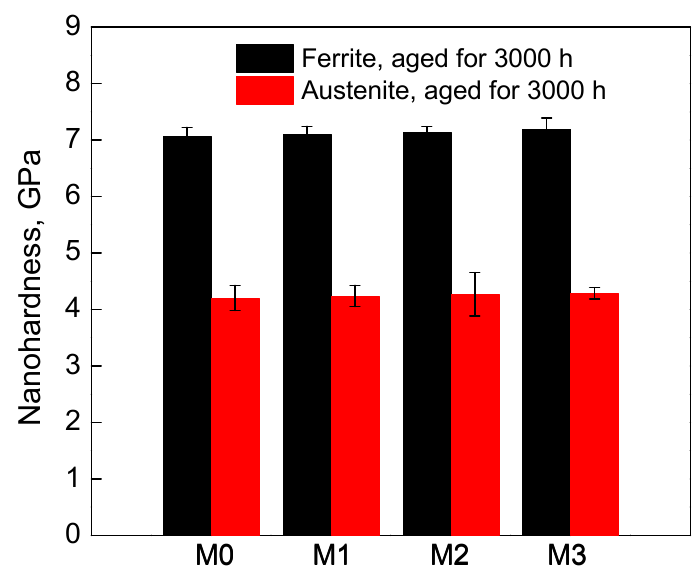
Figure 10. Nanohardness of ferrite and austenite in the aged CDSS specimens.